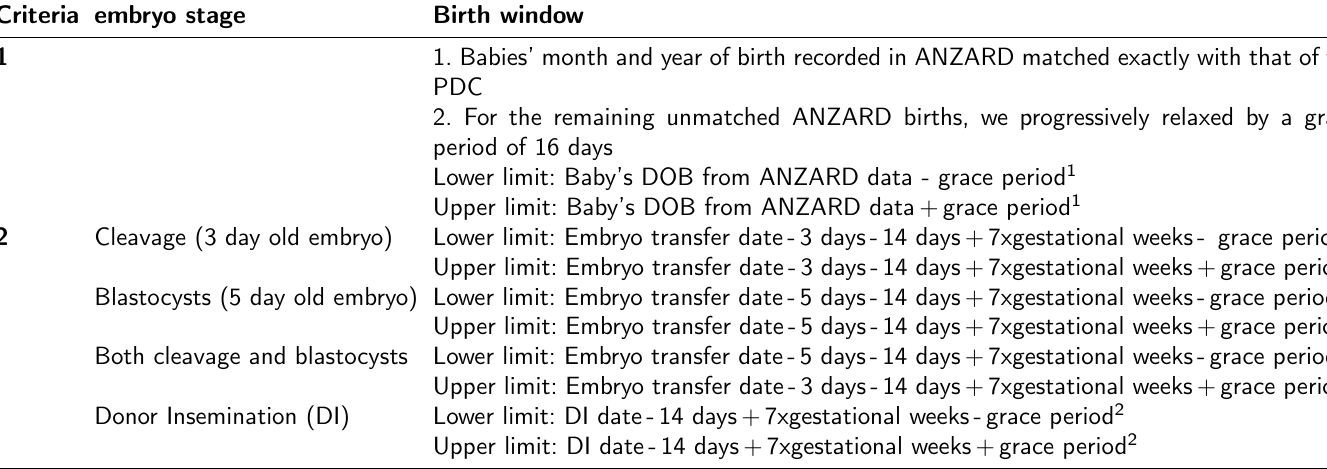
Table 1: Criteria to construct birth windows for examining concordance between ANZARD’s birth records and PDC’s birth records Criteria embryo stage Birth window